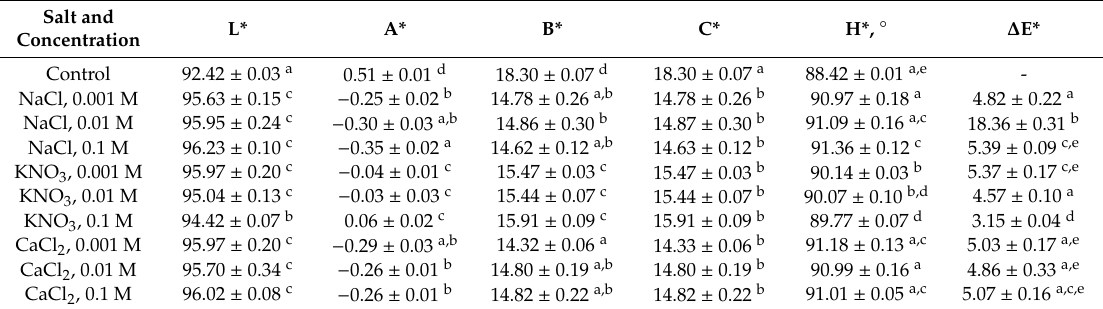
Figure 2B shows that KNO 3 influences the most (and equally) the overall color di ff erence ∆ E*, yellow / blue component b*, red / green component a*, and chromaticity C* (mutual information 0.414 bits). Following, in descending order of influence, are luminosity L* (0.164 bits), hue angle H* (0.086 bits) and antioxidant activity AA (0.04